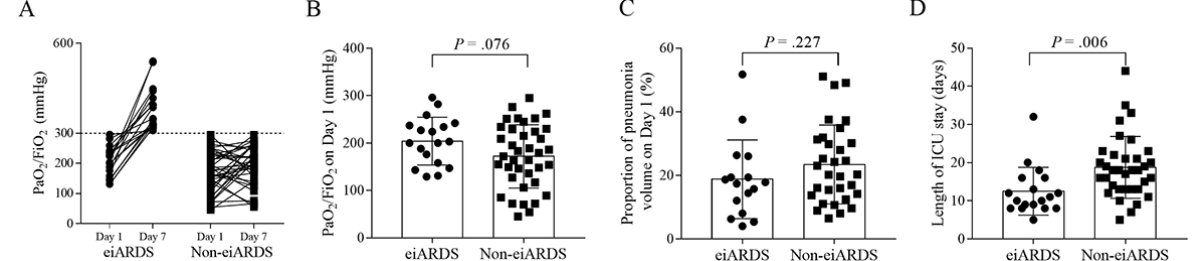
Figure 1. Comparison of patients with and without early improvement of acute respiratory distress syndrome (eiARDS). (A) All patients with ARDS on day 1, divided into two groups (eiARDS and non-eiARDS) according to PaO 2 /FiO 2 on day 7. (B) No significant difference between the two groups in the PaO 2 /FiO 2 on day 1. (C) No significant difference between the two groups in the proportion of pneumonia volume on day 1. (D) The length of intensive care unit stay exhibited differences between the two